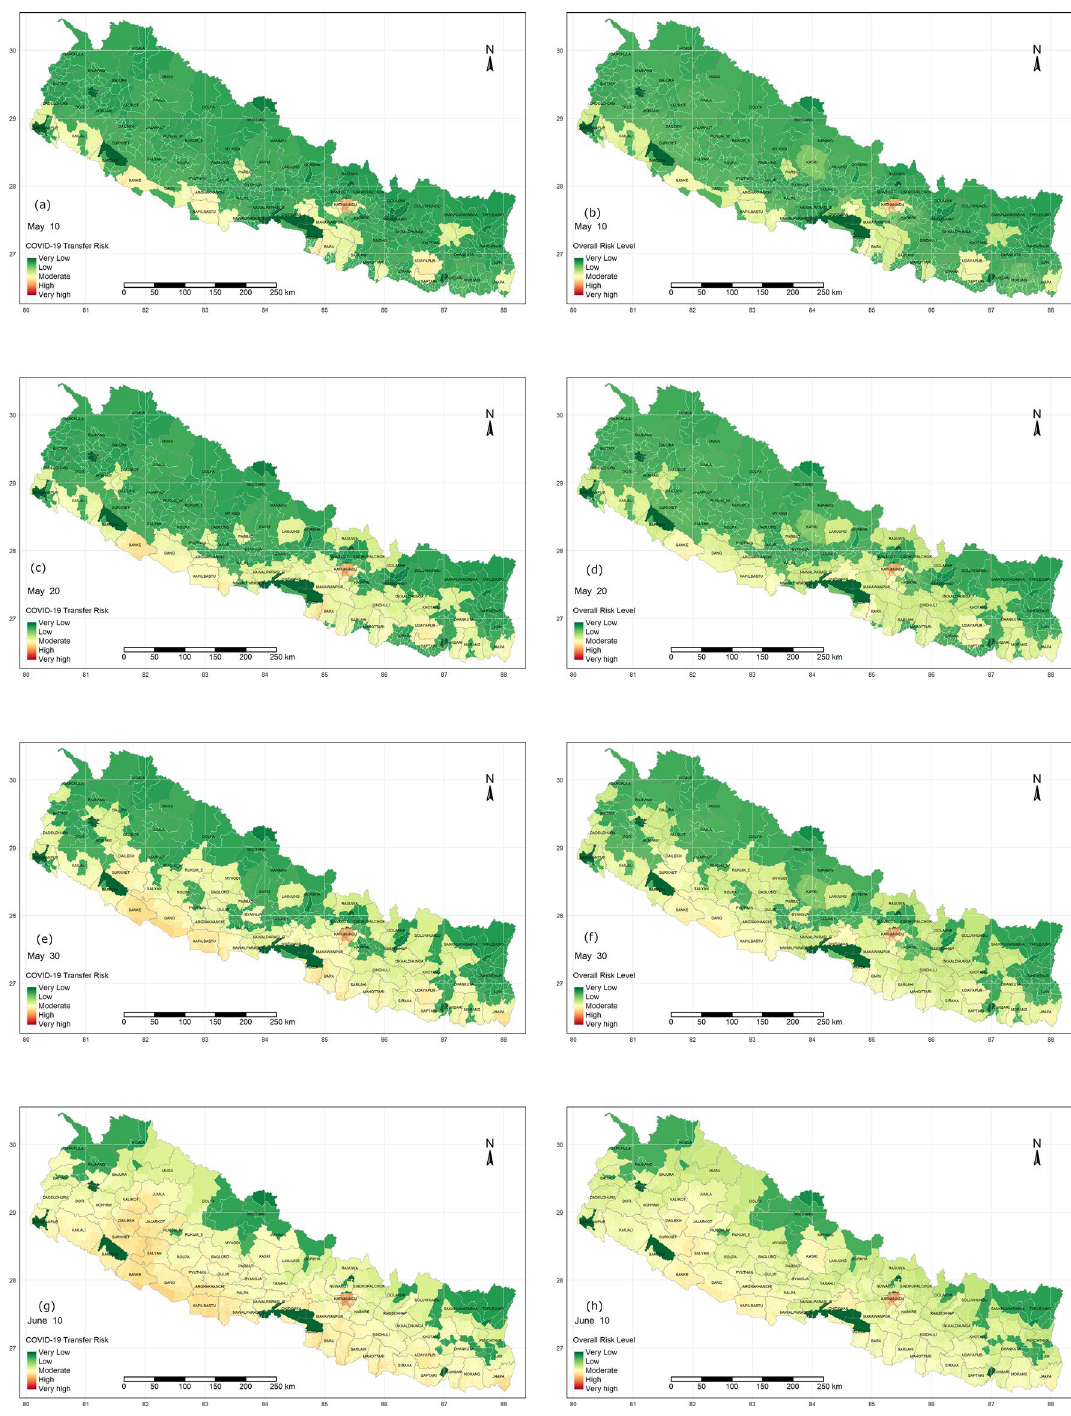
Figure 4. COVID 19 overall risk (right column) and CTR (left column), updated after the positive cases confirmed May 10, 20 and 30 and June 10 from top to bottom. Maps were produced from R programming version 3.5.3; source: https ://cran.r-proje ct.org/bin/windo exposure to infected persons were collected. Data entered by an individual through multiple checkboxes are converted into scores which are then used to calculate risk using the equations above. Personal risk values solely depend on the data provided by the individual, but regional risk assessment, CTR will be the result of the risk in their locality. Result will be provided on the web as shown in Fig. 6. Personalized messages are displayed in brief on information about risk and mitigation measures. Users can find the local risk in selected municipalities through the navigation on the page.